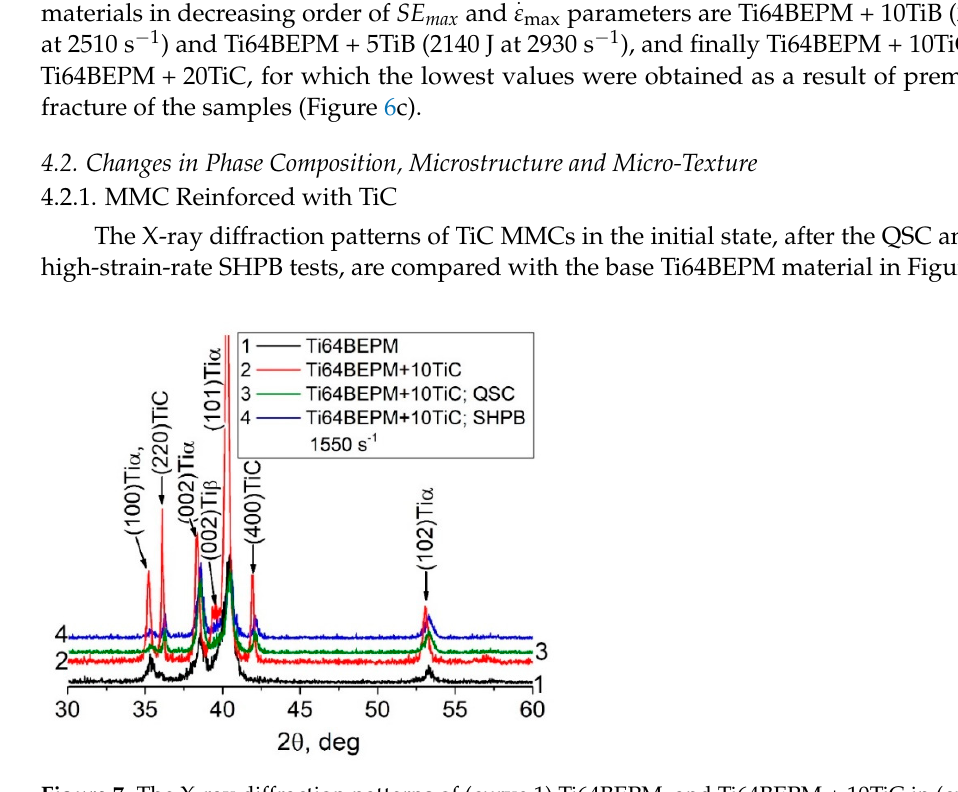
. ε = 10 − 3 s − 1 ) and (curve 4) high-strain-rate SHPB